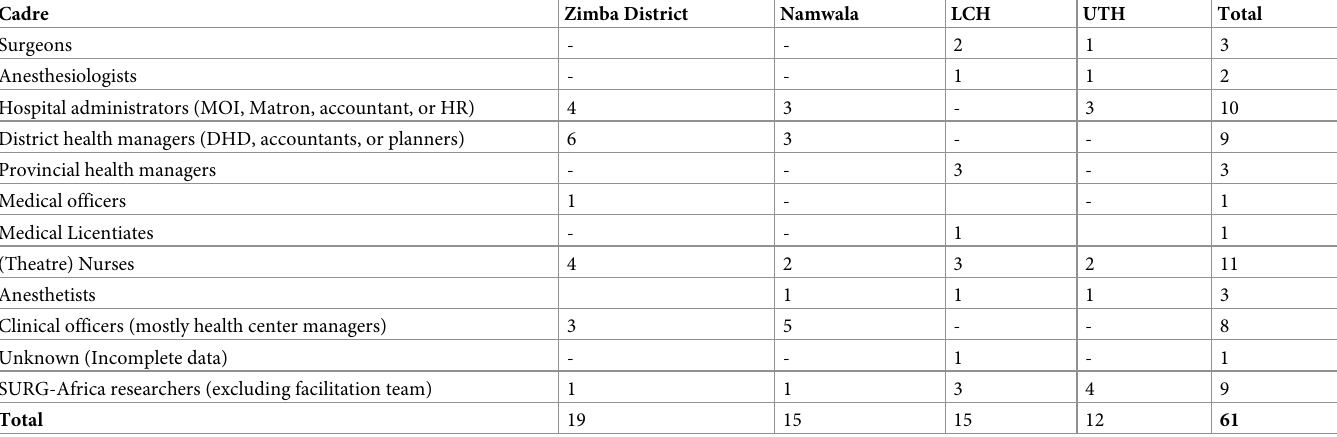
Table 1. Composition (cadre and number) of participants to the group model building